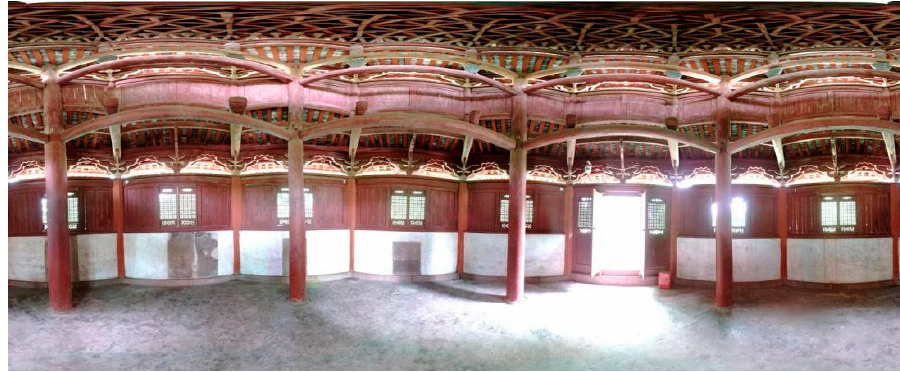
Figure 18. Panoramic images in Xuanluo Hall.